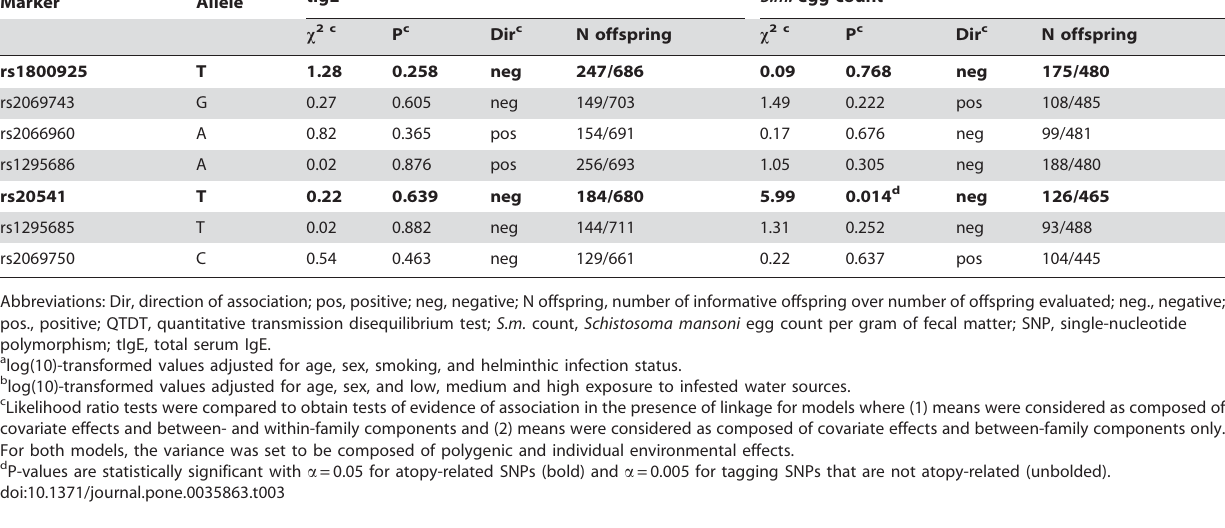
Table 3. QTDT association results for individual IL13 SNPs with tIgE levels and Schistosoma mansoni egg count.